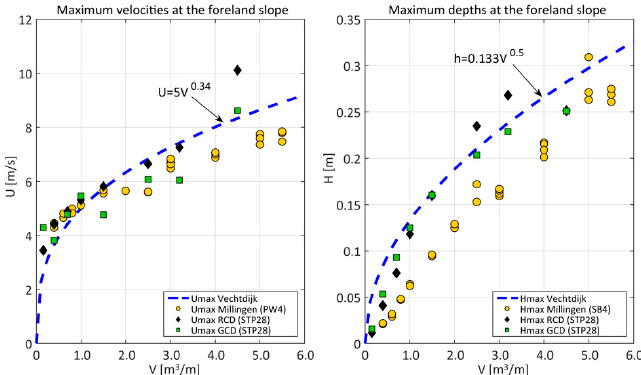
Figure A2. Validation of slope maximum velocity ( Left ) and maximum flow depths ( Right ) at